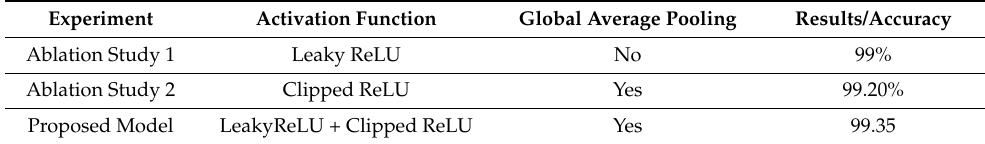
Table 5. Modifying the evaluation network for the ablation study.